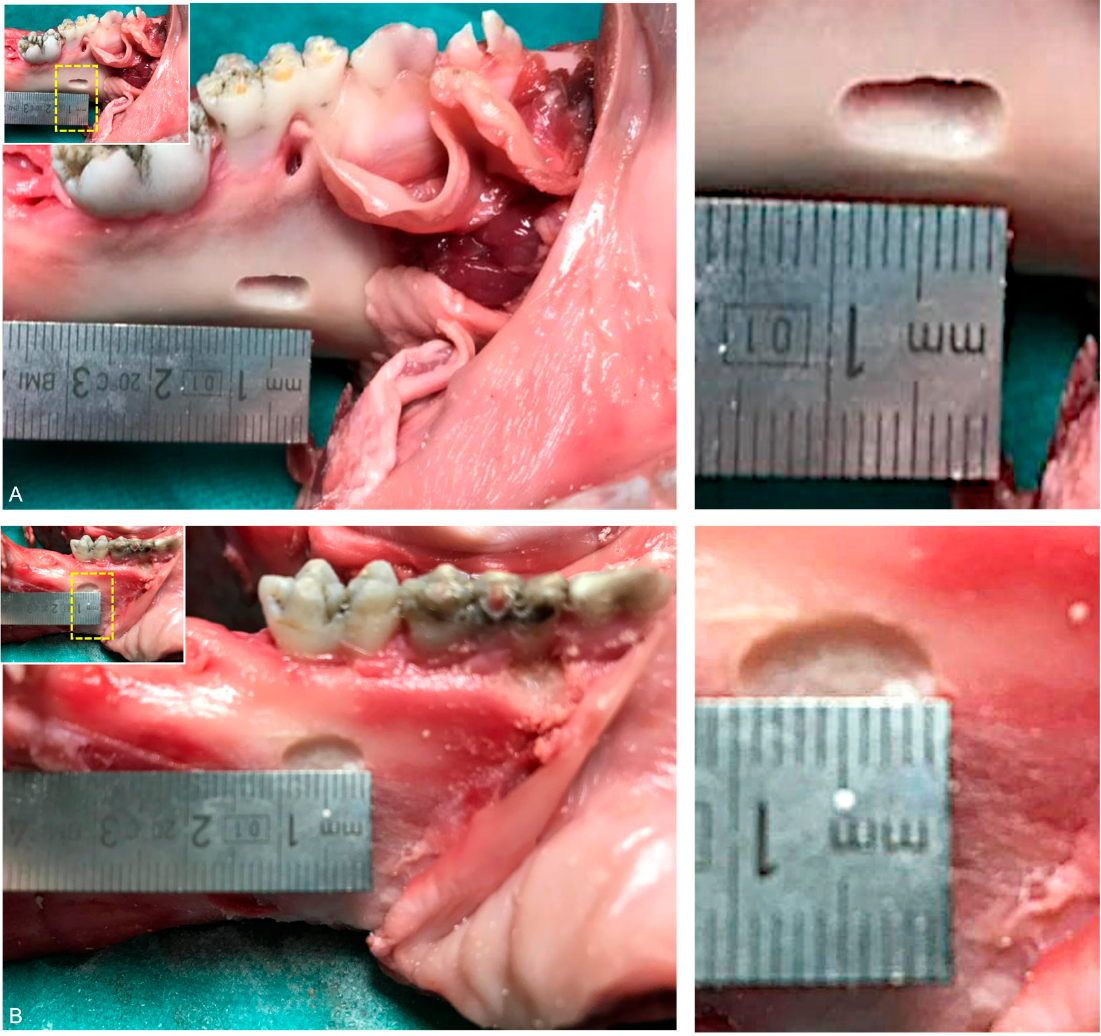
Figure 1. Special drilling instruments (rose head bur H141, Komet Dental, DENTAL Brasseler GmbH, Lemgo, Germany; handpiece Kavo Expertmatic E10C, KaVo Dental AG, Kloten, Switzerland) were used to prepare ( A ) lingual and ( B ) buccal mandibular cystic lesions of the same size after partial removal of soft tissue and epithelium and underwent standard and low-dose CBCT imaging protocols.